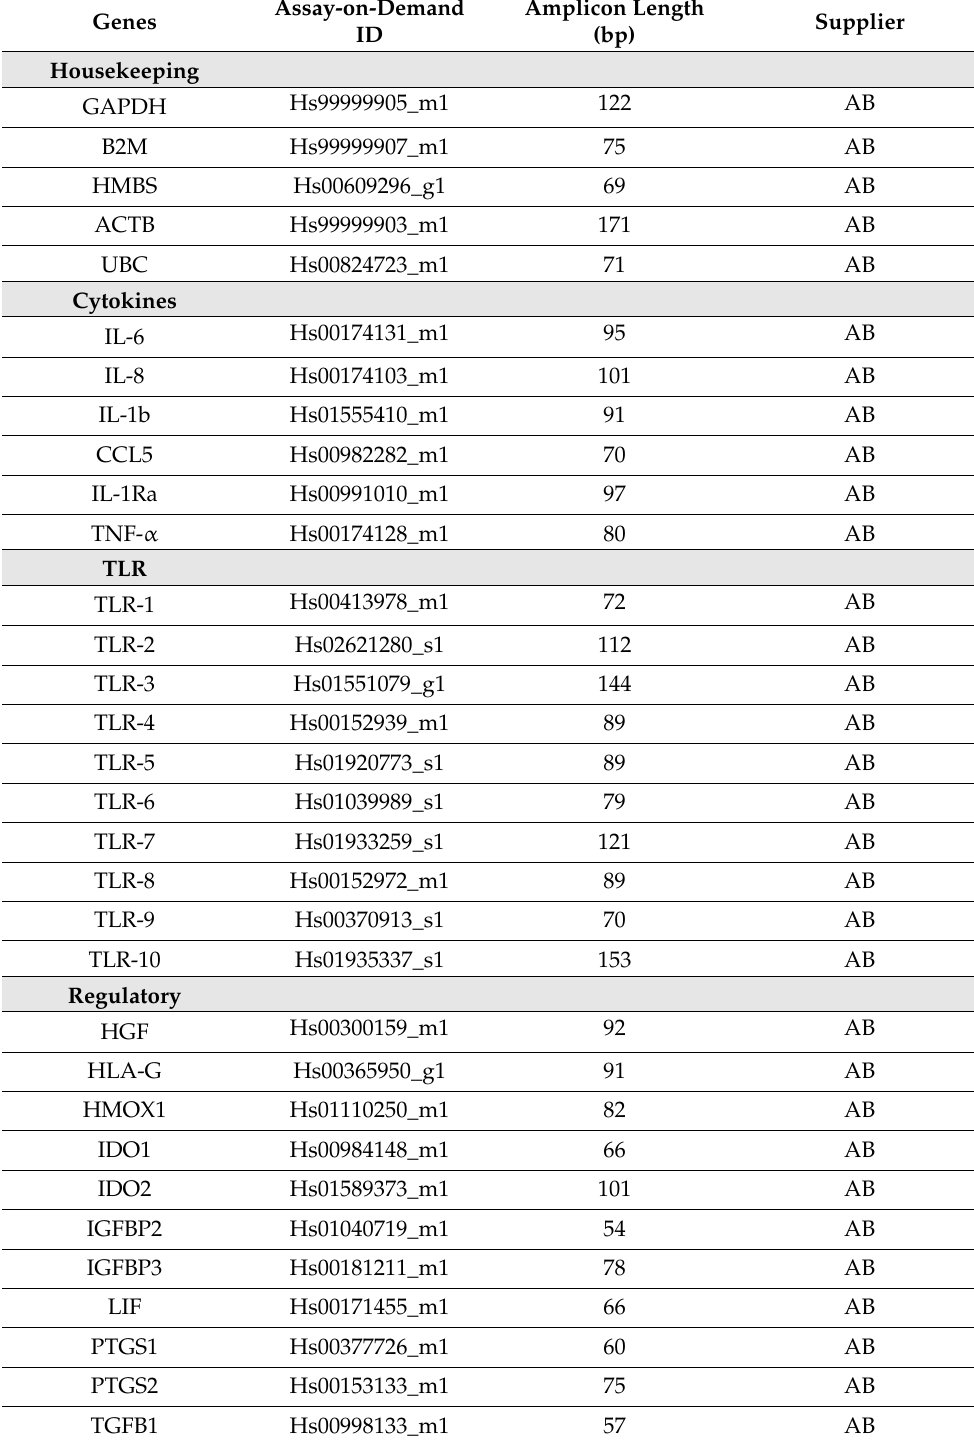
Table 2. Taqman Gene Expression